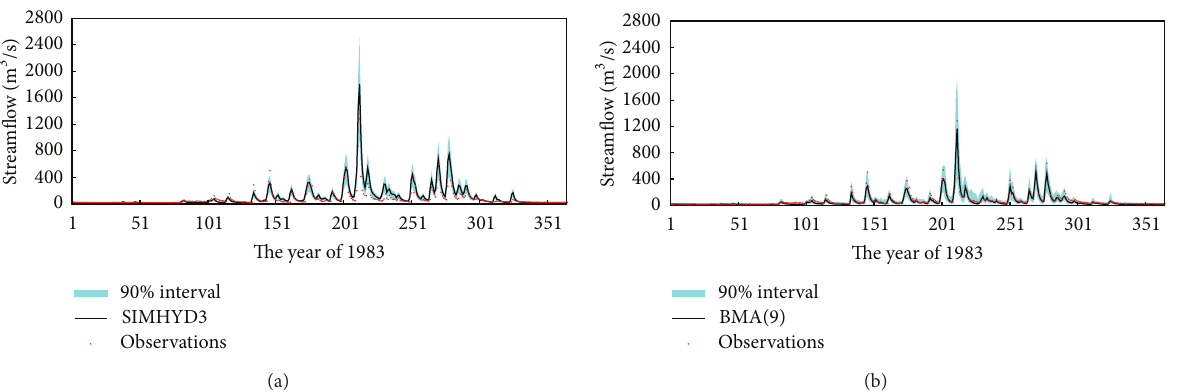
Figure8:Themeanpredictionand90%uncertaintyintervalofbothBMA(9)andSIMHYD3model(theSIMHYDwiththeobjectivefunction OF3) for the Mumahe catchment in 1983 during the calibration